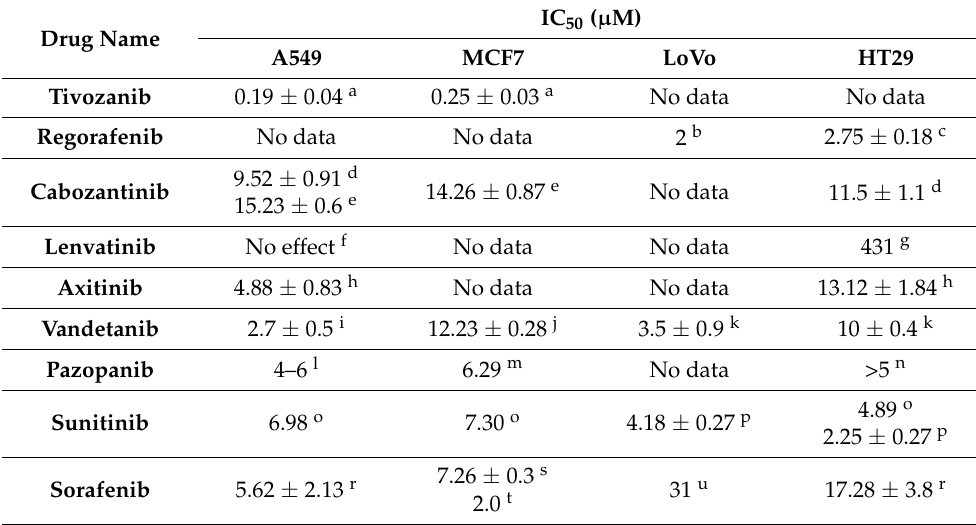
Table 4. Cytotoxic activity (expressed as 50% inhibitory concentration) on the A549, MCF7, LoVo, and HT29 tumor cell lines, collected from the literature, of a few drugs that are confirmed inhibitors of the VEGFR-2 receptor, among